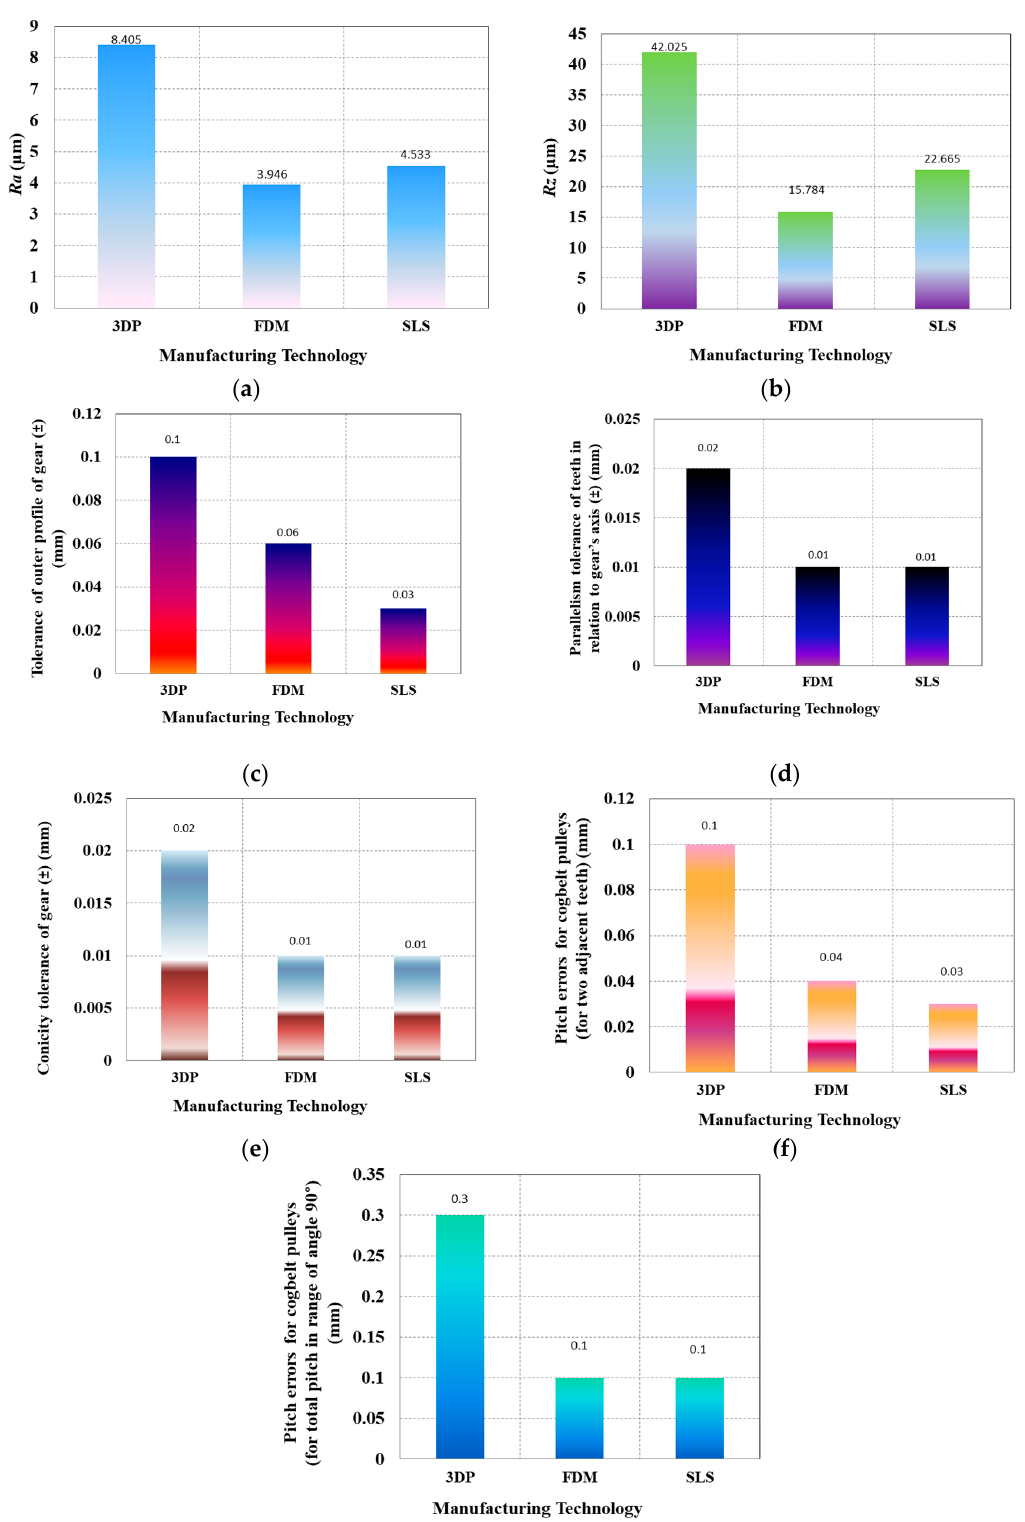
Figure 8. The comparison of various geometrical features for noncircular cogbelt pulleys manufactured with use of additive methods: ( a ) surface roughness Ra ; ( b ) surface roughness Rz, ( c ) tolerance of outer profile of gear; ( d ) parallelism tolerance of teeth in relation to gear’s axis; ( e ) conicity tolerance of gear (for width 0.5”); ( f ) pitch errors for cogbelt pulleys (for two adjacent teeth); ( g ) pitch errors for cogbelt pulleys (for total pitch in range of angle 90°).